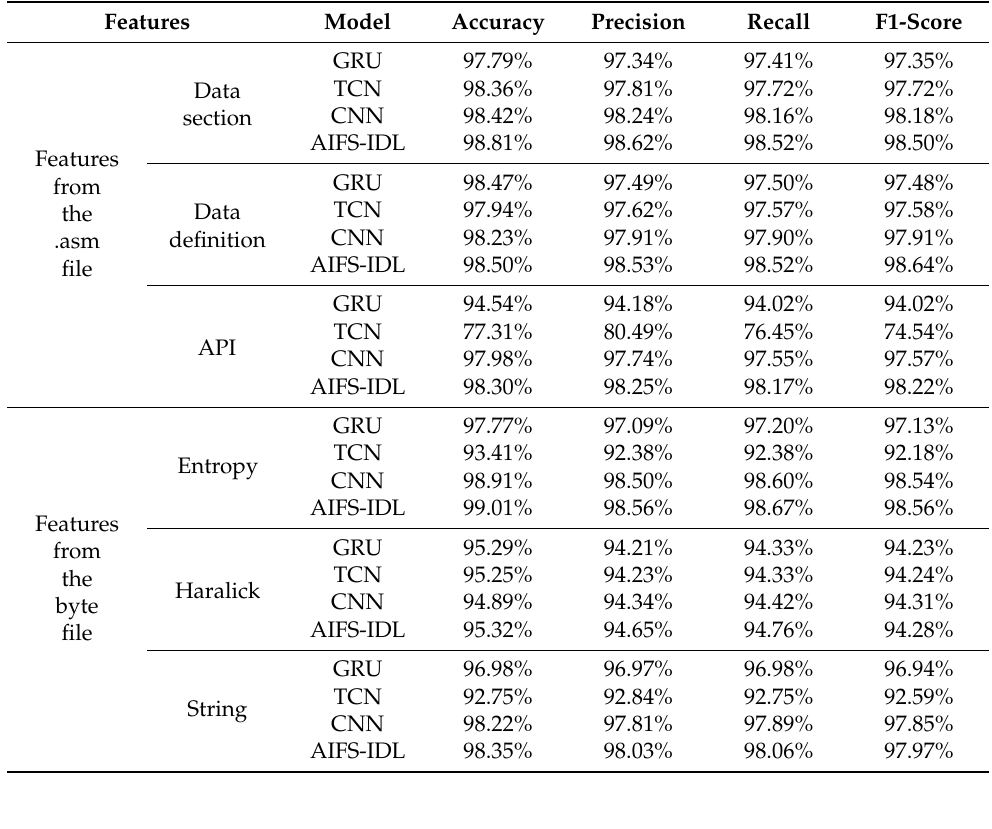
Table 4. Single-feature comparison experiment results.